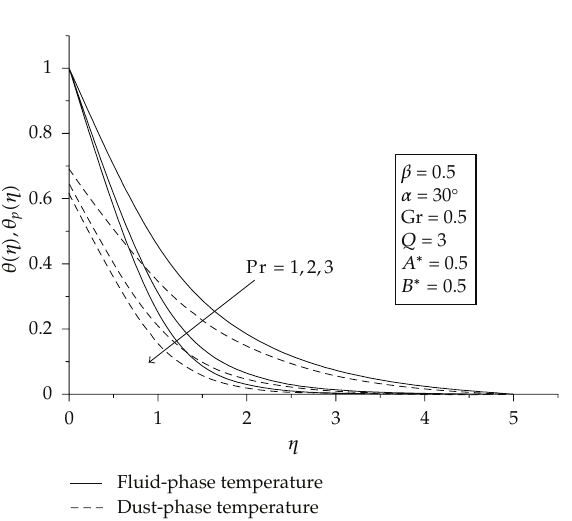
Figure 10: Temperature profile for di ff erent values of Prandtl